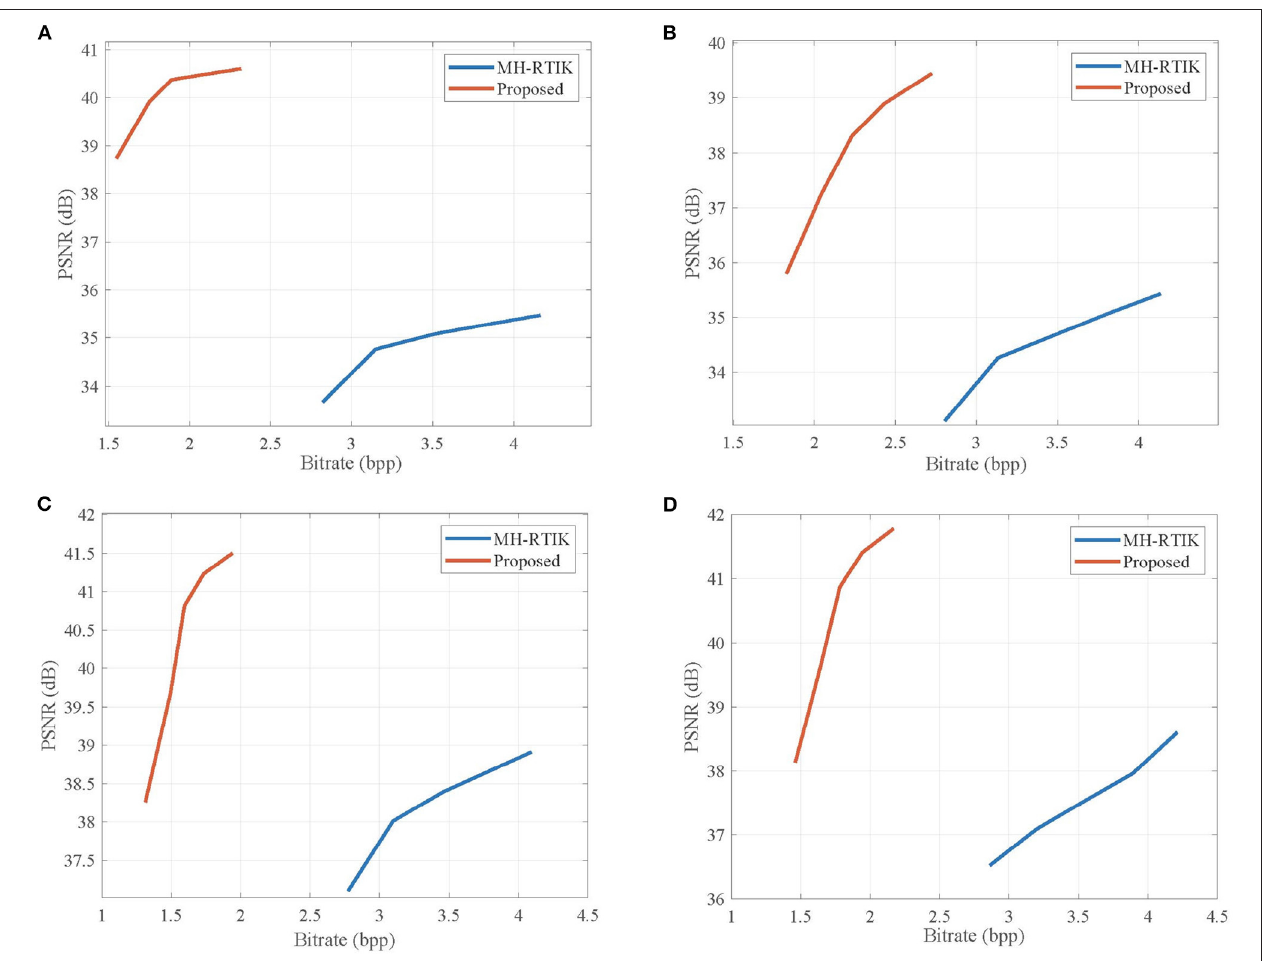
FIGURE 11 | Rate-distortion curves obtained by the proposed CVS system and Multi-Hypothesis TIKhonov (MH-TIK) (Chen C. et al., 2020) for (A) Container , (B) Coastguard , (C) Hall , and (D) Foreman sequences. Note that the length L of GOP is set to be 2.